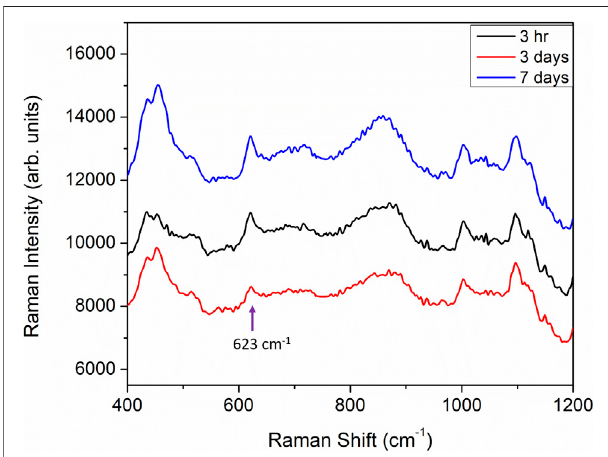
FIGURE 6 | SERS spectra of heroin obtained from sensors functionalized with 20 mM KI for 30 min and exposed to a 100 μ g/ml heroin solution for 30 min. After the KI functionalization, the sensors were stored in ambient for 3 h (black trace), 3 days (red trace) and 7 days (blue trace) before heroin